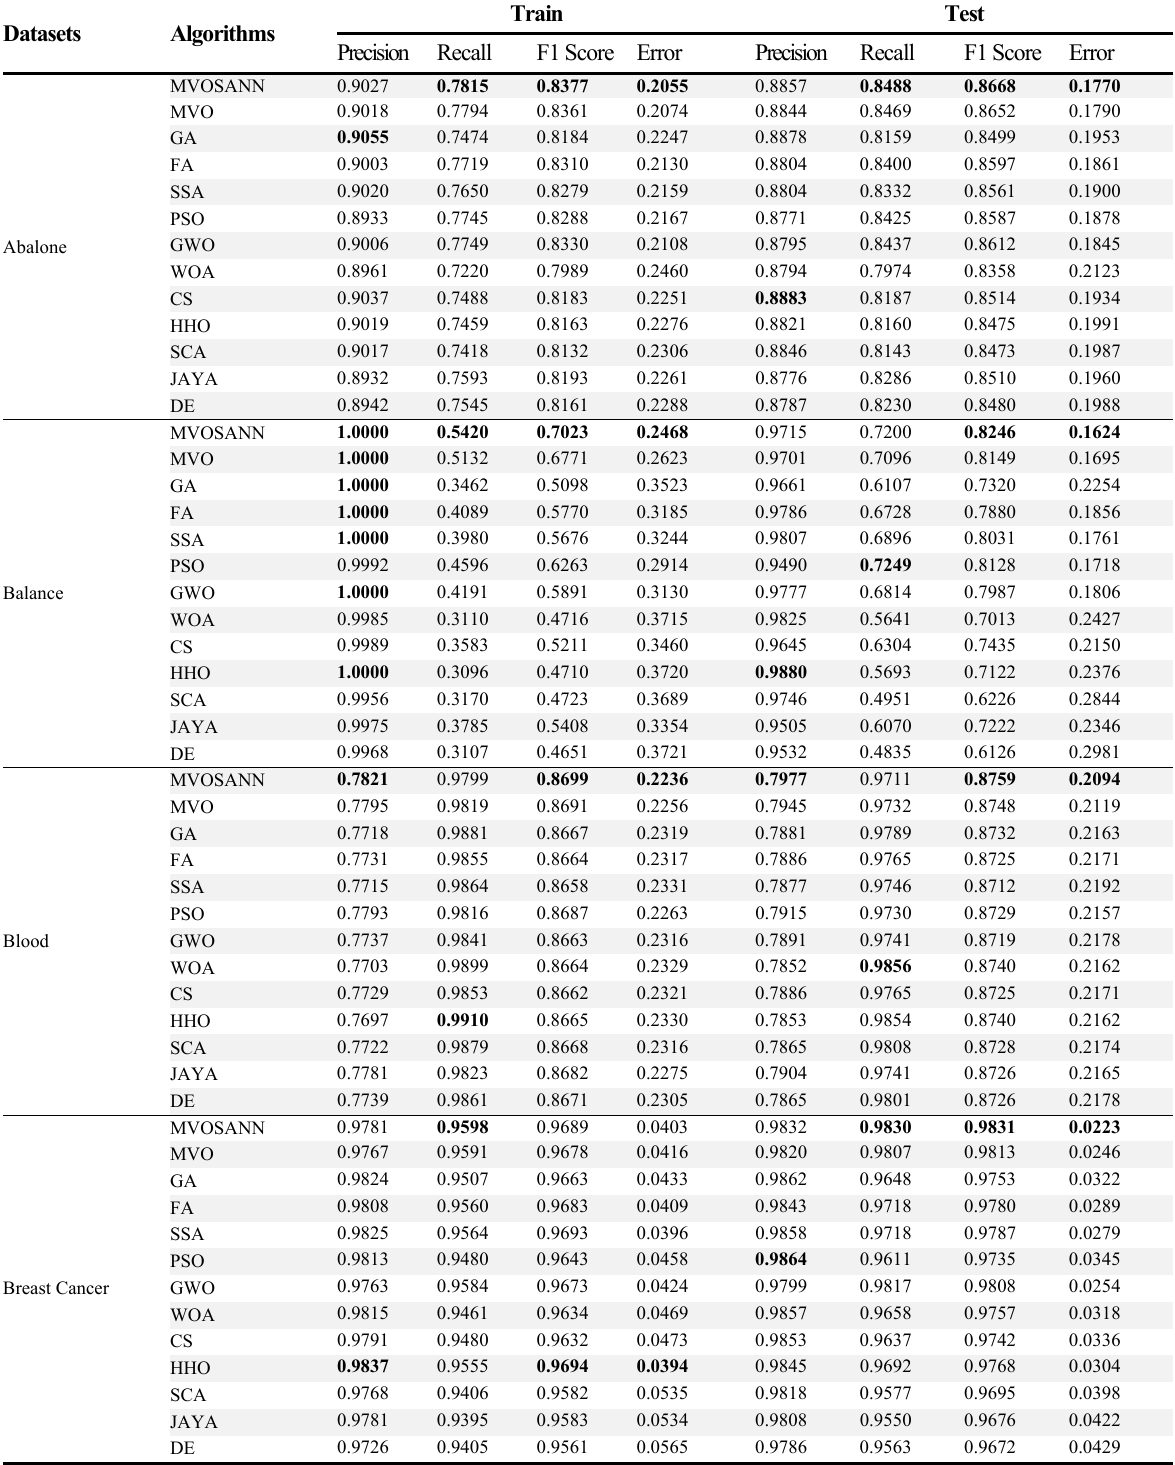
Table 6 Results of precision, recall, F1 score, error rate for all datasets (continued overleaves)